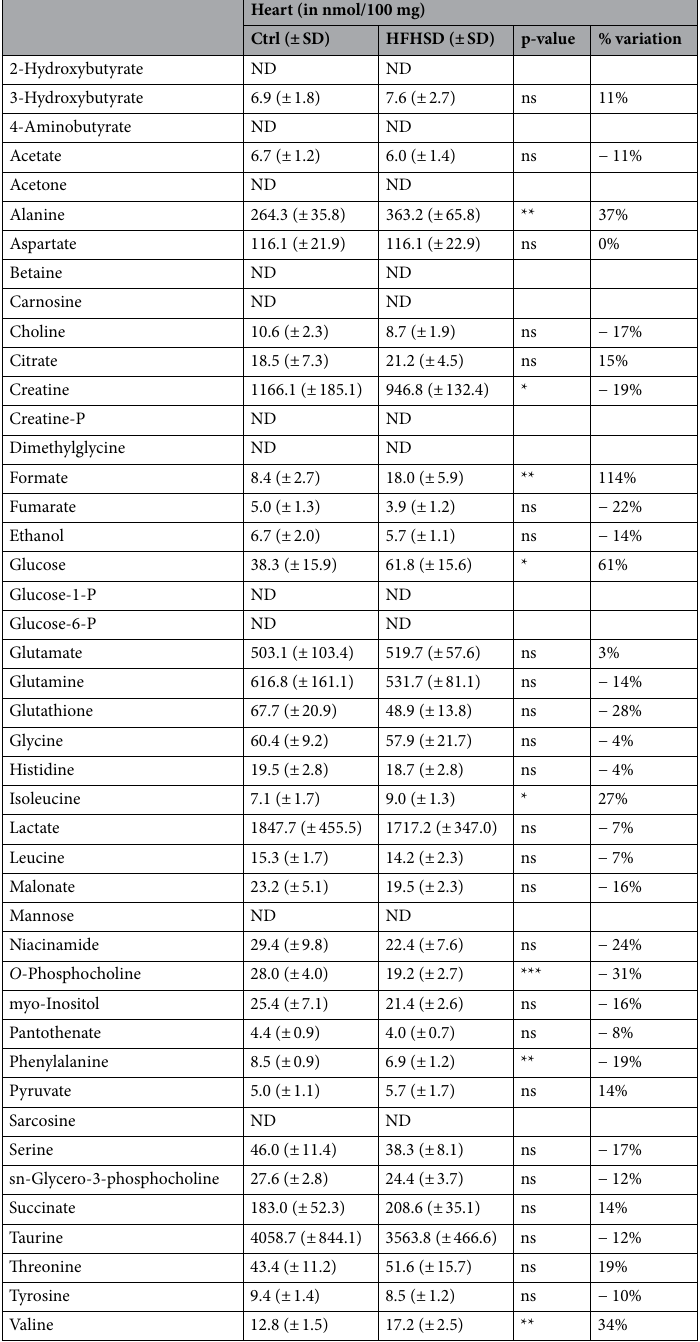
Table 5. Metabolite concentrations measured by NMR in the heart of SD and HFHSD mice. Results are expressed as mean ± standard deviation (SD) and are in nmol/100 mg of heart. Data are mean of n = 8 mice per group; Results of unpaired two-tailed t-test are indicated as non-determined (ND), non-significant (NS), p < 0.05 (*), p < 0.01 (**), p < 0.001 (***) and p < 0.0001 (****). Percentages of variation between HFHSD and control fed mice are